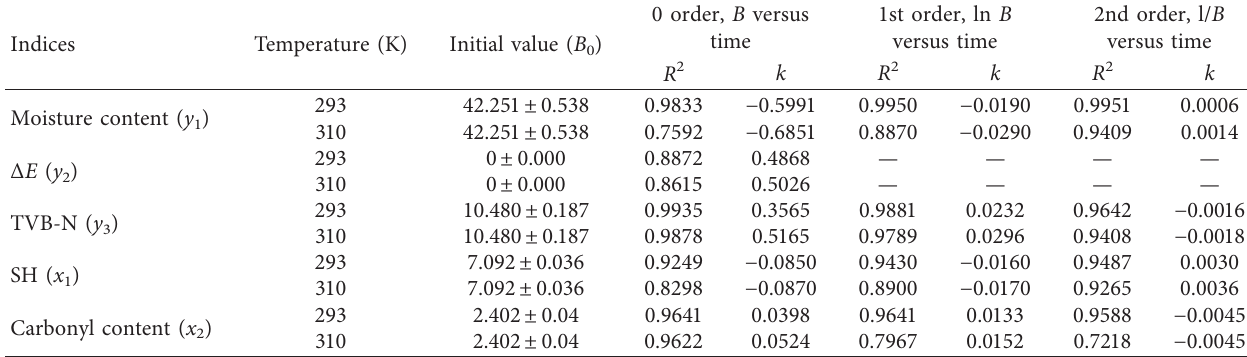
Table 2: Estimation of the order of quality change of dried shrimps by examining the regression coefficient ( R 2 ) and rate constant ( k ) from plots of zero-, first-, and second-order reactions.